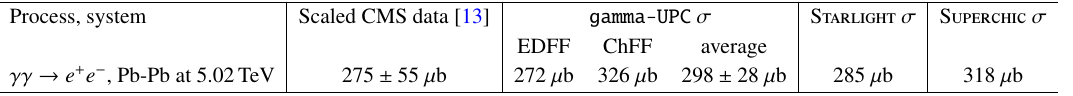
p = 5 : 02 TeV ( E e s > T NN